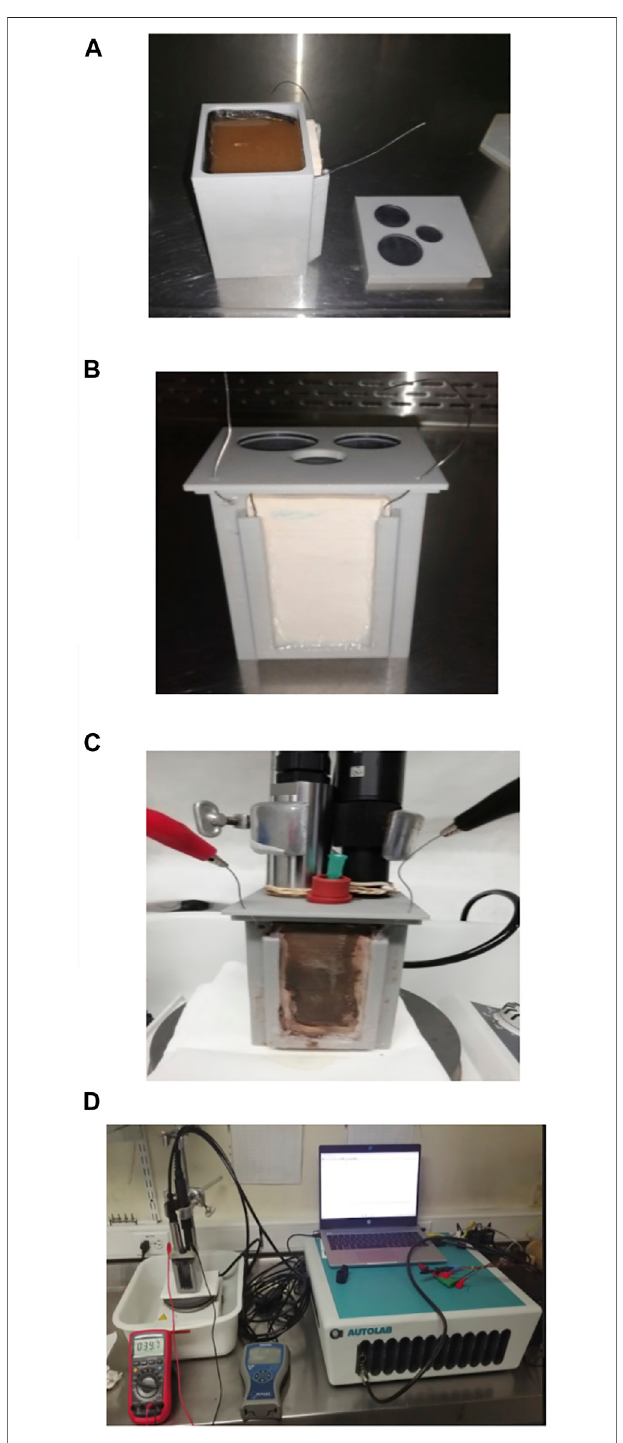
FIGURE 2 | Prototype Microbial Fuel Cell made of polymer and with ceramicmembrane. (A) DetailofMFCassemblywiththeanodechamber fi lled with fresh coffee wastewater used as feedstock. (B) Front view of MFC prototype assembly showing the ceramic membrane. (C) MFC assembly with sensors and probes adapted. (D) Detail of MFC set up